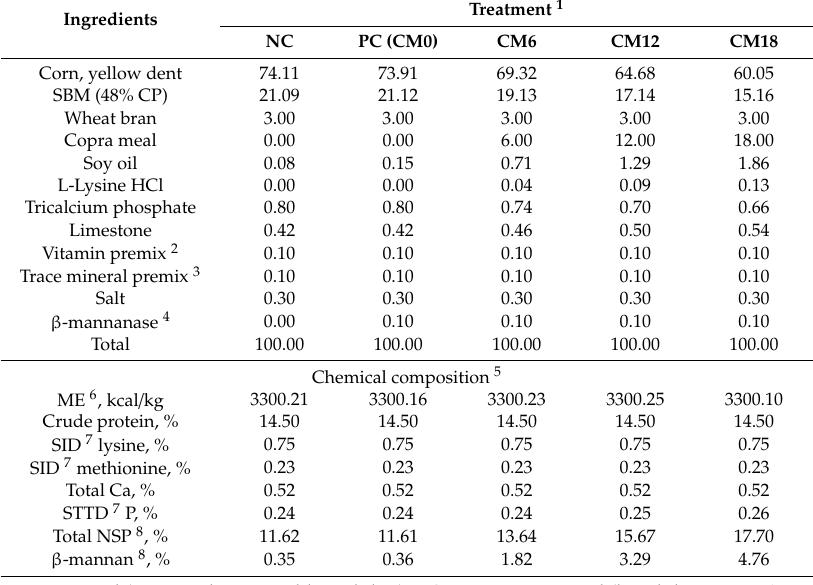
Table 3. The formula and chemical composition of experimental diets in finishing I phase. Ingredients